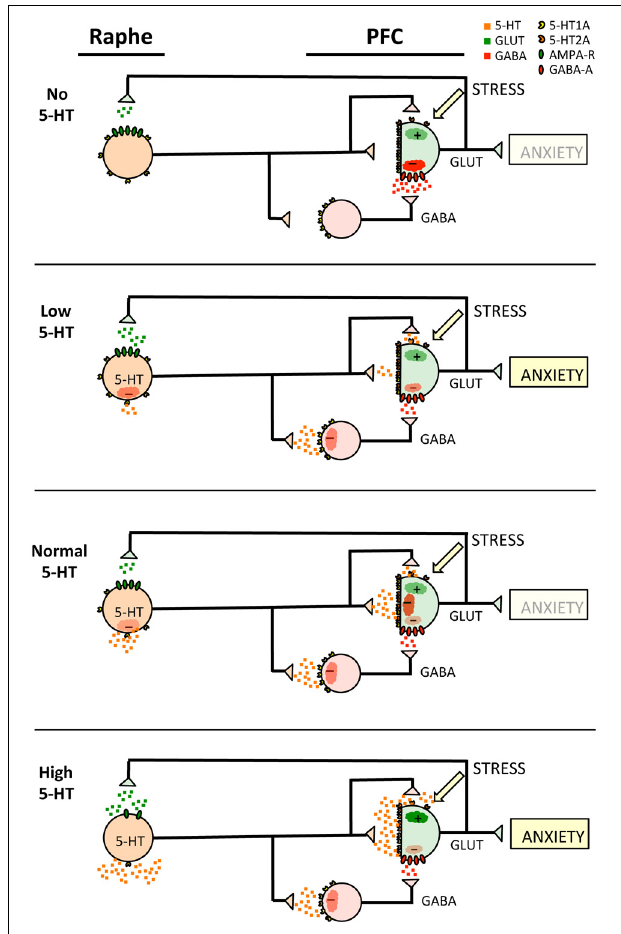
FIGURE 1 | Early post-natal 5-HT-PFC circuitry in anxiety models. Shown are the components of the Raphe 5-HT-PFC circuit in animals during the early post-natal period with no, low, normal or high levels of 5-HT neurotransmission as indicated. Evidence from genetic mouse models ( Table 1 ) supports the importance of alterations in early post-natal circuitry in generating the adult anxiety phenotype. The model shows 5-HT neurons (orange) projecting to prefrontal cortex GABAergic interneurons (red) and glutamatergic pyramidal neurons (green) with transmitter release illustrated as small squares of the same colors. Although 5-HT neurons are shown projecting separately to glutamatergic or GABAergic PFC neurons to illustrate the different activities of these pathways, the same 5-HT neuron may innervate both cells with different efficiency synapses or varicosities (Bang et al., 2012). The presence of 5-HT1A (yellow), 5-HT2A (orange) and GABA-A receptors (red) is shown, as well as the response in the target neurons (clouds), stimulatory ( + ) or inhibitory ( − ). The effect of chronic stress to stimulate pyramidal output is also indicated. It is postulated that 5-HT1A-mediated inhibition in the early post-natal period and perhaps adult is greater in interneurons than pyramidal neurons and that increased pyramidal neuronal activity triggers the anxiety phenotype, especially during the early post-natal period.